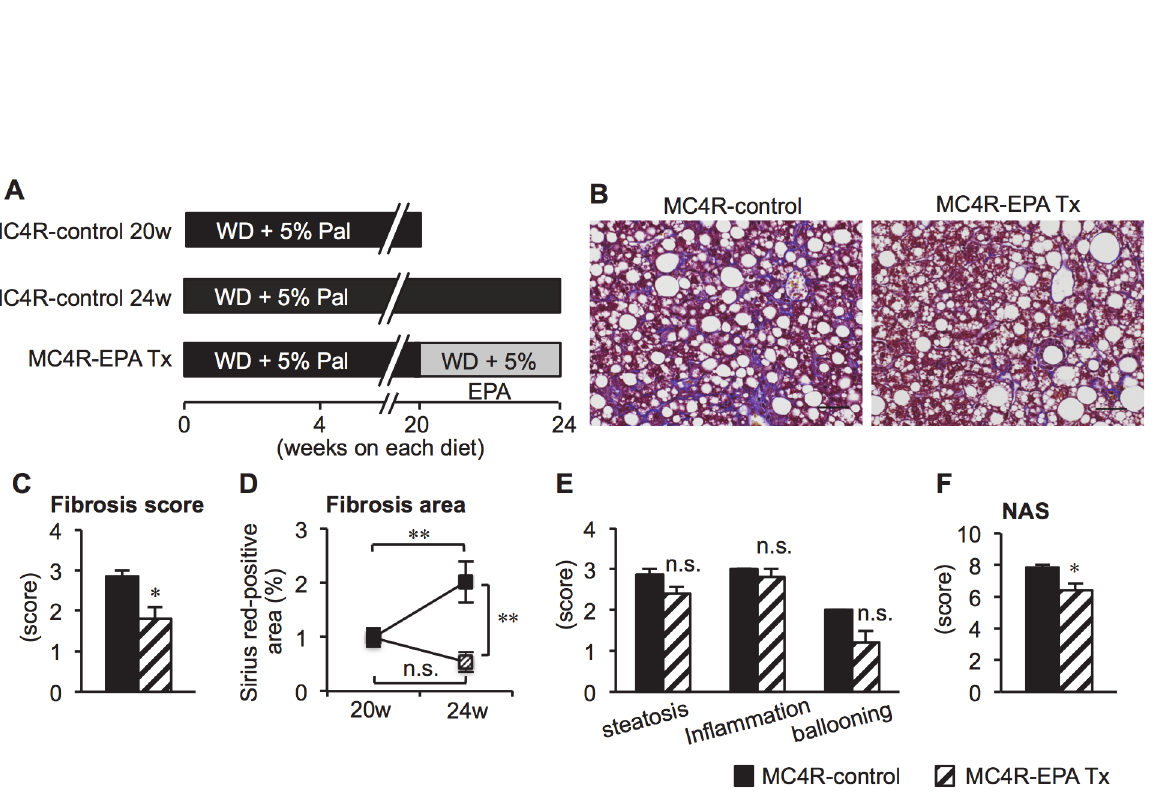
PLOS ONE | DOI:10.1371/journal.pone.0121528 March 27,